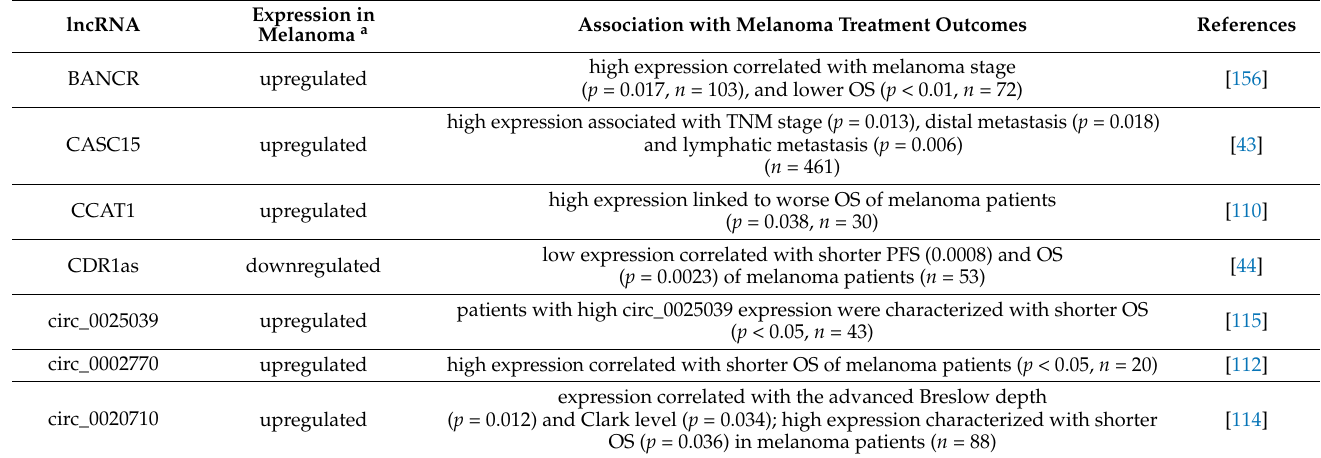
Table 3. lncRNAs as prognostic markers in